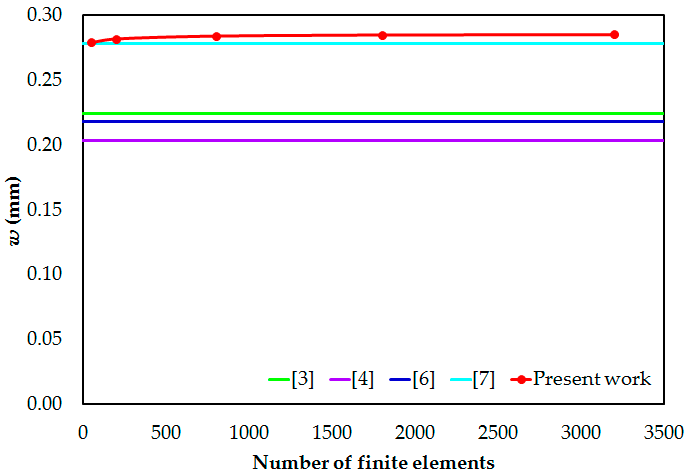
Figure 4. Stiffened plate computational model verification.